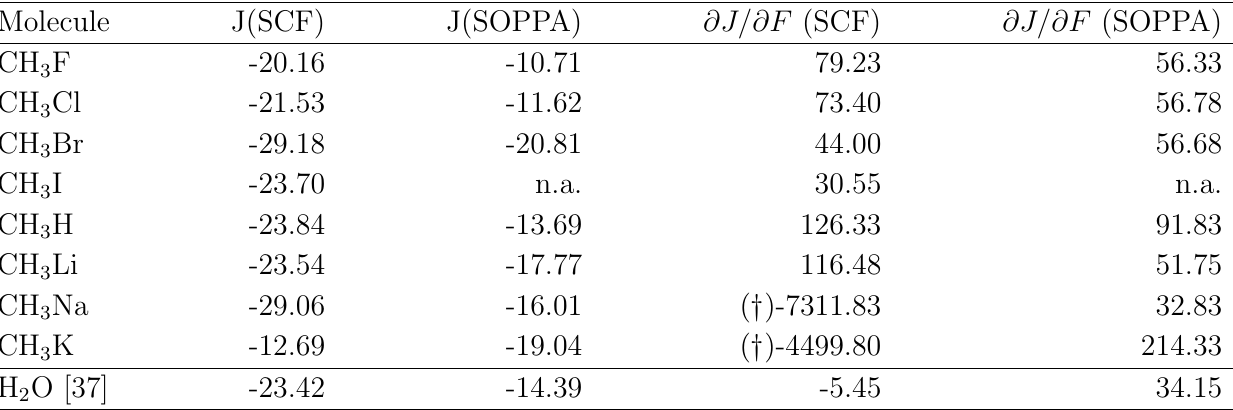
Table 3. Table of Calculated J and their Field Derivatives (All Js are in units of Hz,